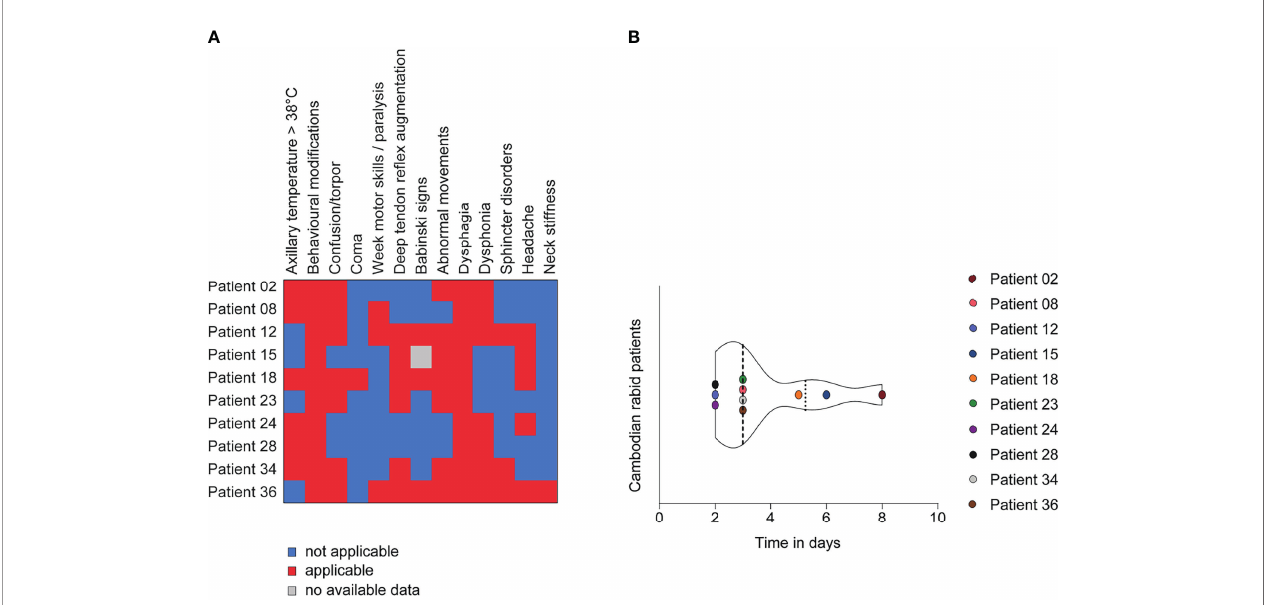
FIGURE 2 | Clinical presentation of Cambodian rabid patients from group 1 (n=10). (A) Description of the clinical signs and symptoms of Cambodian rabid patients. (B) Time between the onset of symptoms and death in days observed for Cambodian rabid patients. (A, B) A detailed overview of the clinical presentation of Cambodian rabid patients belonging to group 1 can be found in Supplementary Table S1